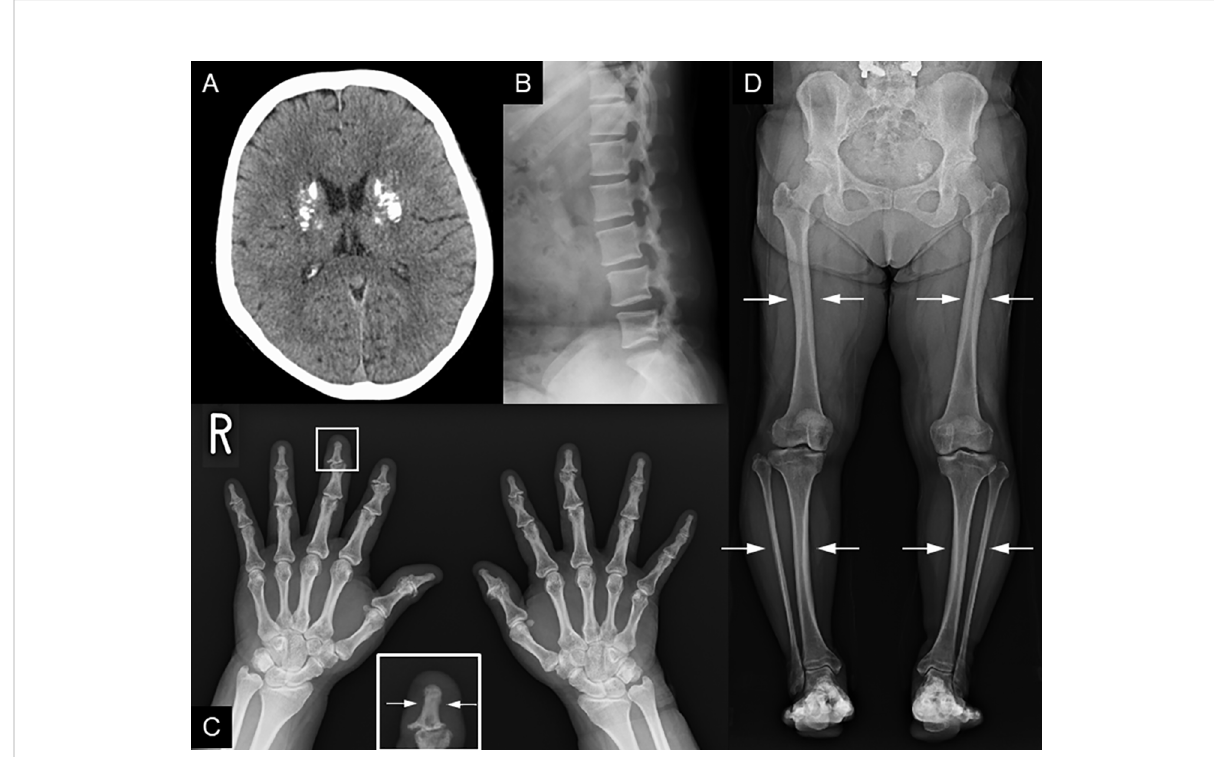
FIGURE 2 Radiological fi ndings. (A) Head CT shows coarse calci fi cation of the capsule. (B) Preoperative image of lumbar spondylolisthesis at age 48. Disc space irregularity is seen between L4 and L5. (C, D) Cortical thickening of the bones, particularly of the (C) fi ngers and lower leg bones (i.e, femur, tibia, and fi bula). (D) Medullary stenosis of bones is also